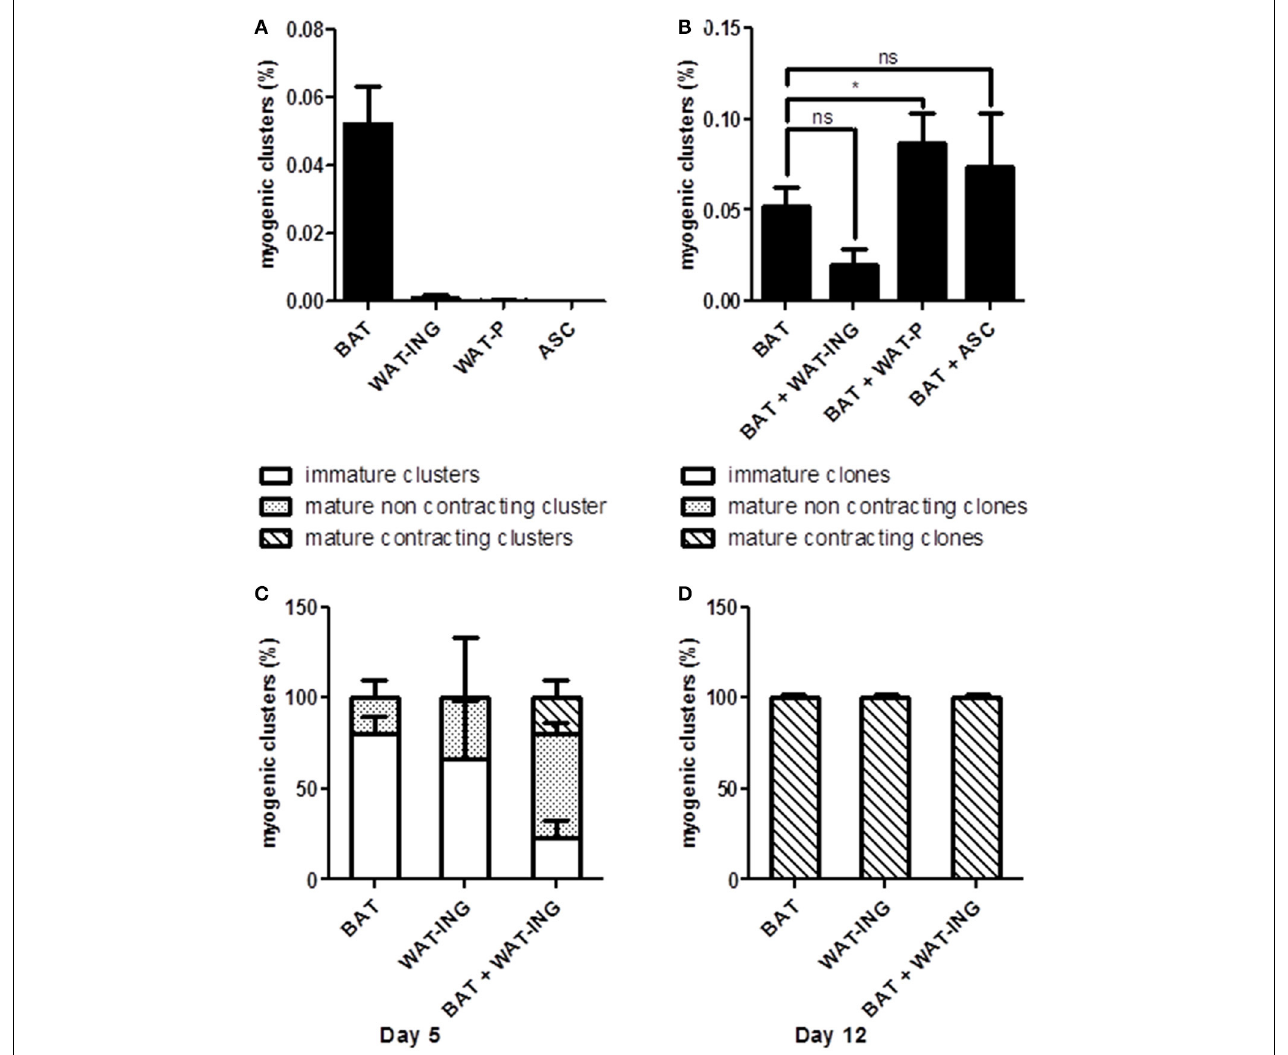
FIGURE 5 | Microenvironment influence on myogenic clusters emergence. (A) Quantification of myogenic clusters generated 8 days after independent plating of BAT, WAT-ING, and WAT-P SVF cells and inguinal pad derived ASC. Results are expressed as percentage of total plated cells. (B) Quantification of myogenic clusters generated 8 days after co-culture of BAT SVF cells with WAT-ING or WAT-P SVF cells or inguinal pad derived ASC.